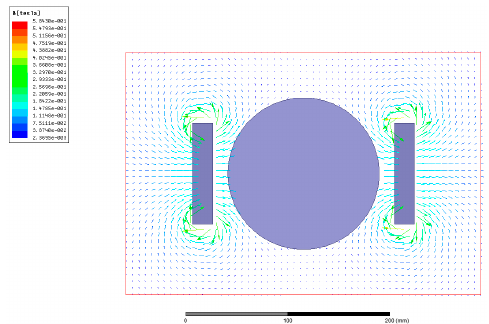
Figure 4. Magnetic-induction intensity distribution.